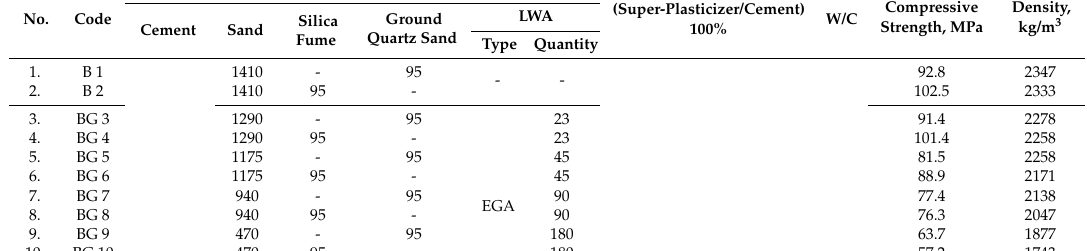
Table 2. Mix proportions, compressive strength, and density of LWAC with EGA and ECA. No.